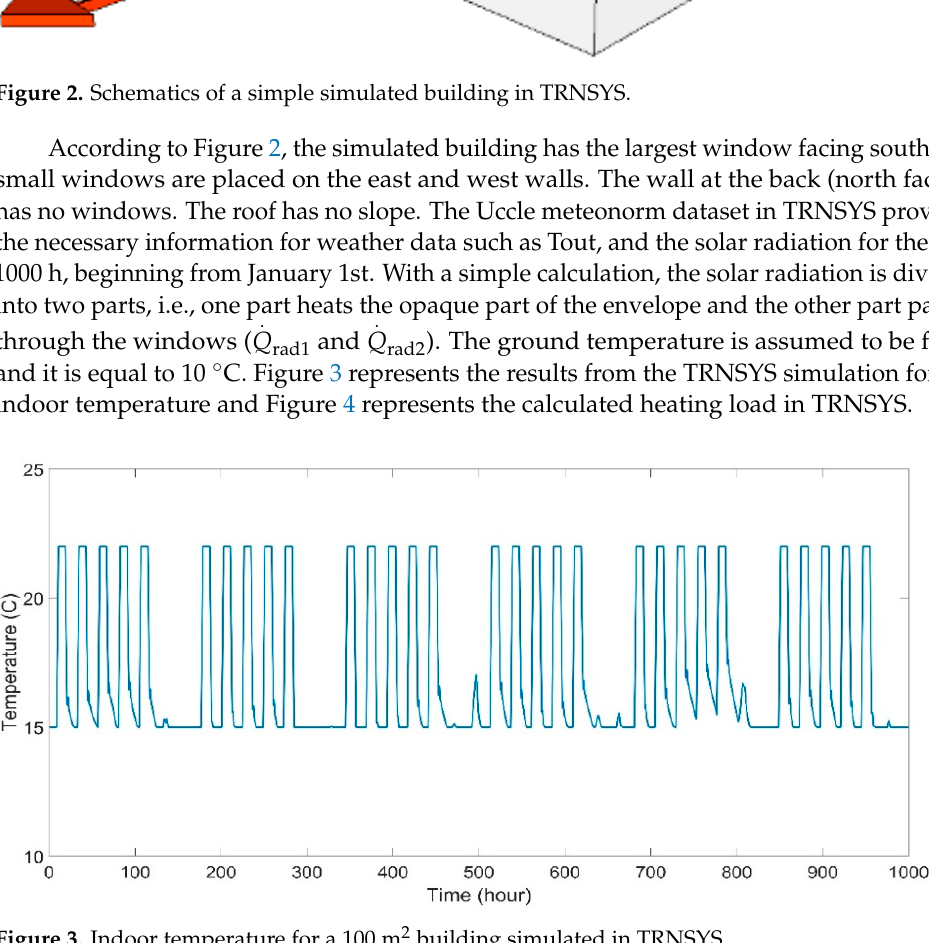
Figure 4. Determined heat power for a 100 m 2 building simulated in TRNSYS. 2.3. Real Building Measurements The other dataset used in this study stems from a real building that is constructed as part of the project IEA annex 58 [21]. The Twin Houses N2 and O5 in Holzkirchen, Ger ‐ many, were tested and detailed measurements of the indoor and weather conditions are provided to be used for system identification. It is shown that the two houses have almost the same heating load profile to keep the set temperatures. The detailed information about the building location, geometry, construction, and conducted experiments is provided in the manual [28]. The tested building contains nine thermal zones, including attic, cellar, living room, corridor, kitchen, bathroom, hallway, and two bedrooms, as shown in Figure 5. The avail ‐ able datasets contain detailed measurements such as indoor temperature, humidity ratio, heat demand, infiltration, and ventilation rates of each zone. The weather data is also measured on site, including outdoor temperature, global solar radiation on each orienta ‐ tion, ground temperature, wind speed, and humidity ratio.